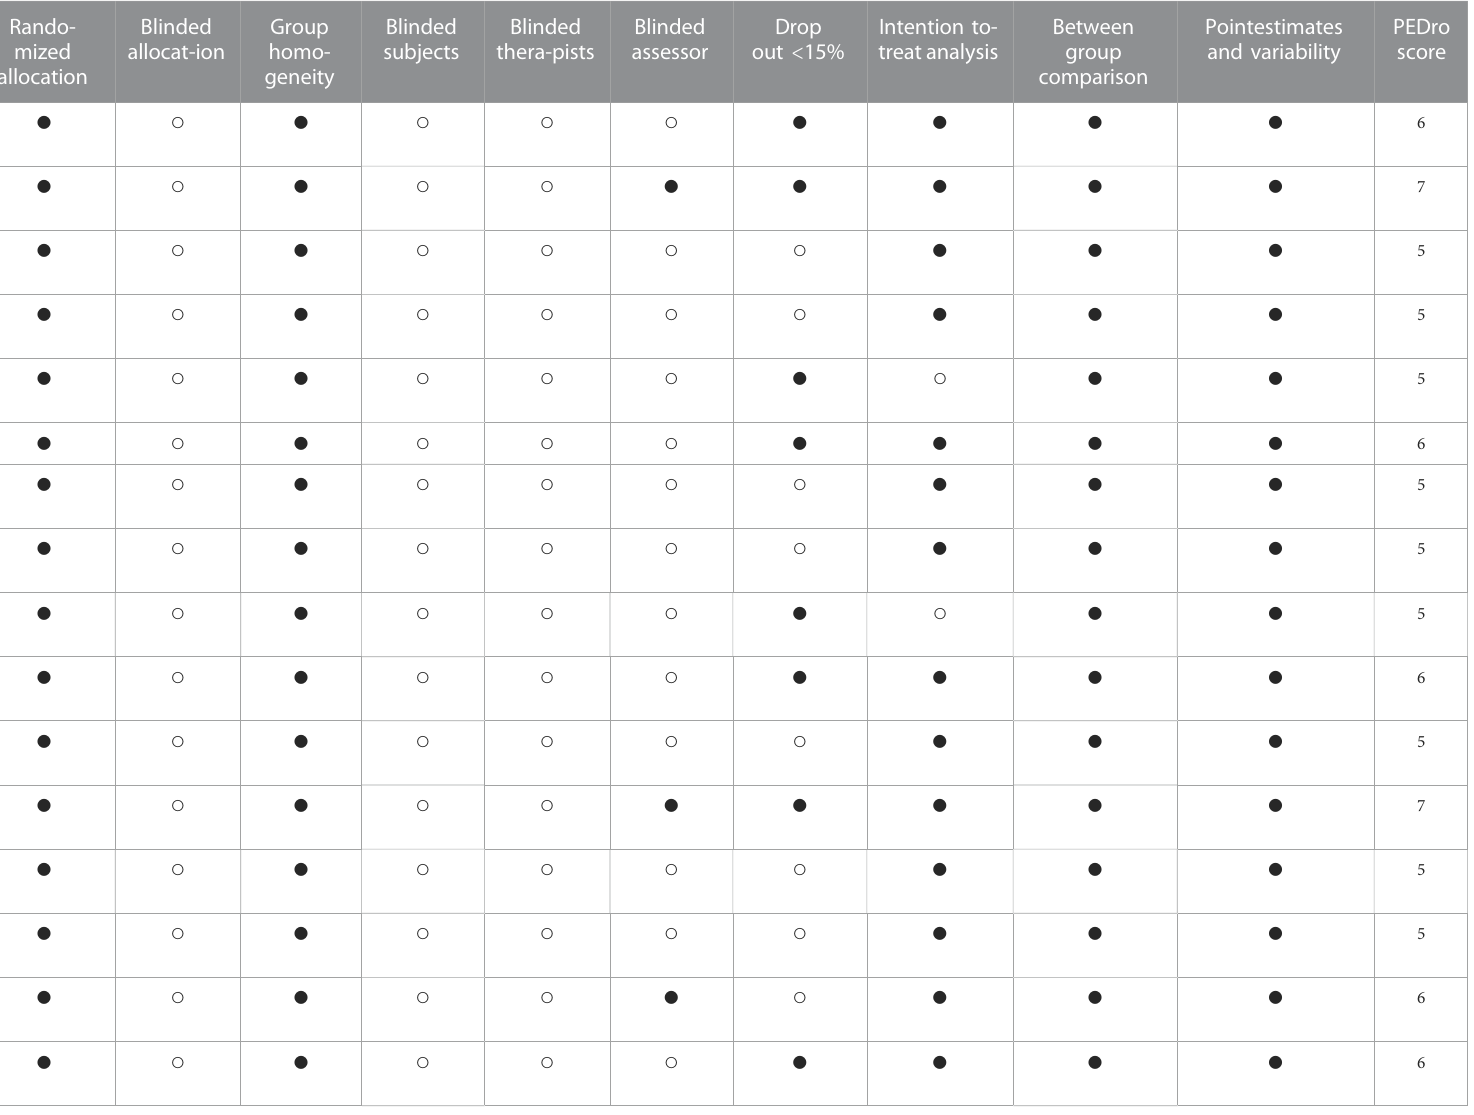
TABLE 3 The Physical therapy evidence database (PEDro)